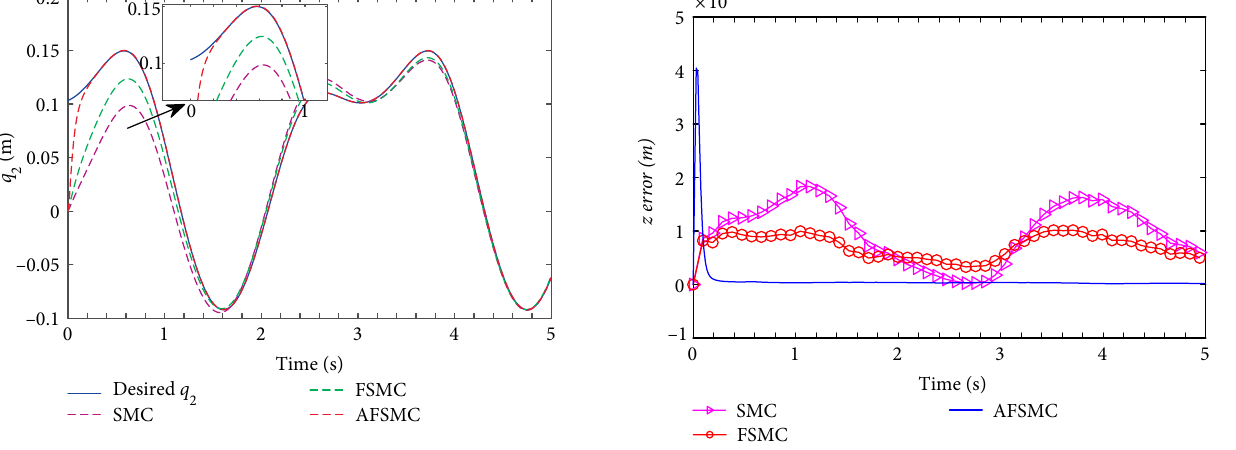
Figure 14: The tracking response of the second limb q